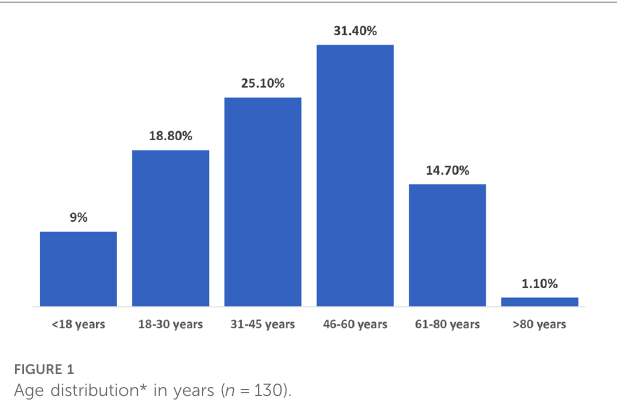
FIGURE 1 Age distribution* in years ( n